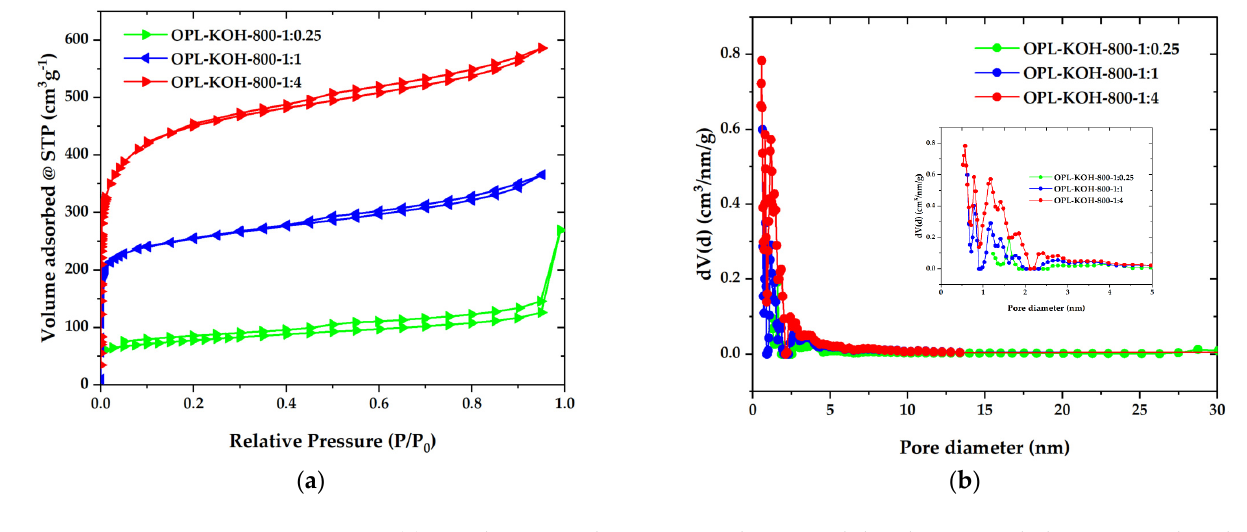
Figure 4. ( a ) N 2 adsorption–desorption isotherms. Solid and open symbols represent the adsorption and desorption data, respectively. ( b ) DFT pore size distribution of OPL − KOH − 800 − 1:0.25, Table 2. Structural parameters of OPL − KOH − 800 − 1:0.25, OPL − KOH − 800 − 1:1, and OPL − KOH − 800 − 1:4 from N 2 adsorption.